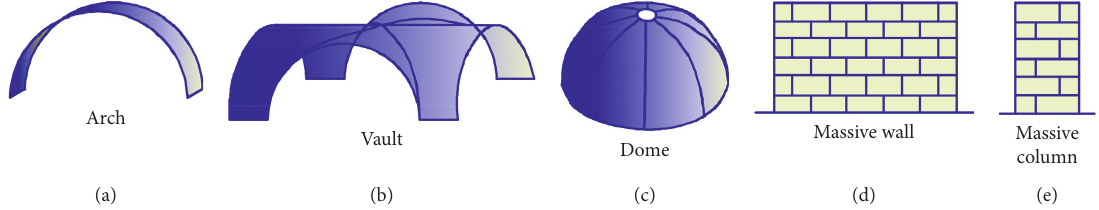
Figure 2: The schemes of preferred load-bearing systems of masonry structures. (a) Arch (b) Vault. (c) Dome. (d) Massive wall. (e) Massive column.